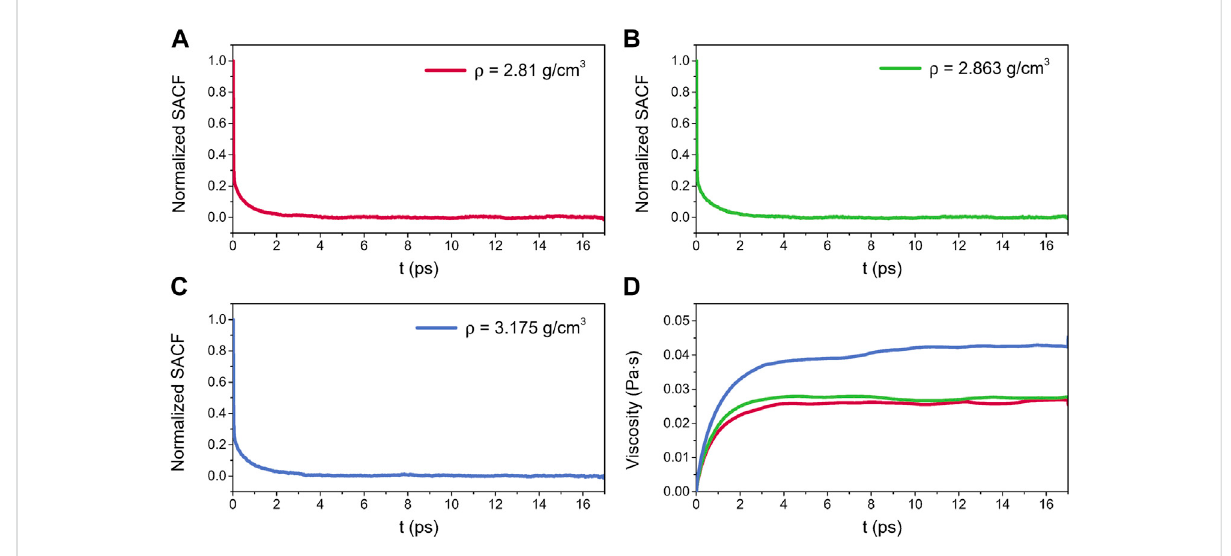
FIGURE 12 Normalized SACFs for liquid alumina at 2500 K as a function of the correlation time, (A) ρ = 2.81 g/cm 3 , (B) ρ = 2.863 g/cm 3 and (C) ρ = 3.175 g/ cm 3 , (D) viscosities for liquid alumina at 2500 K and three densities as a function of the correlation